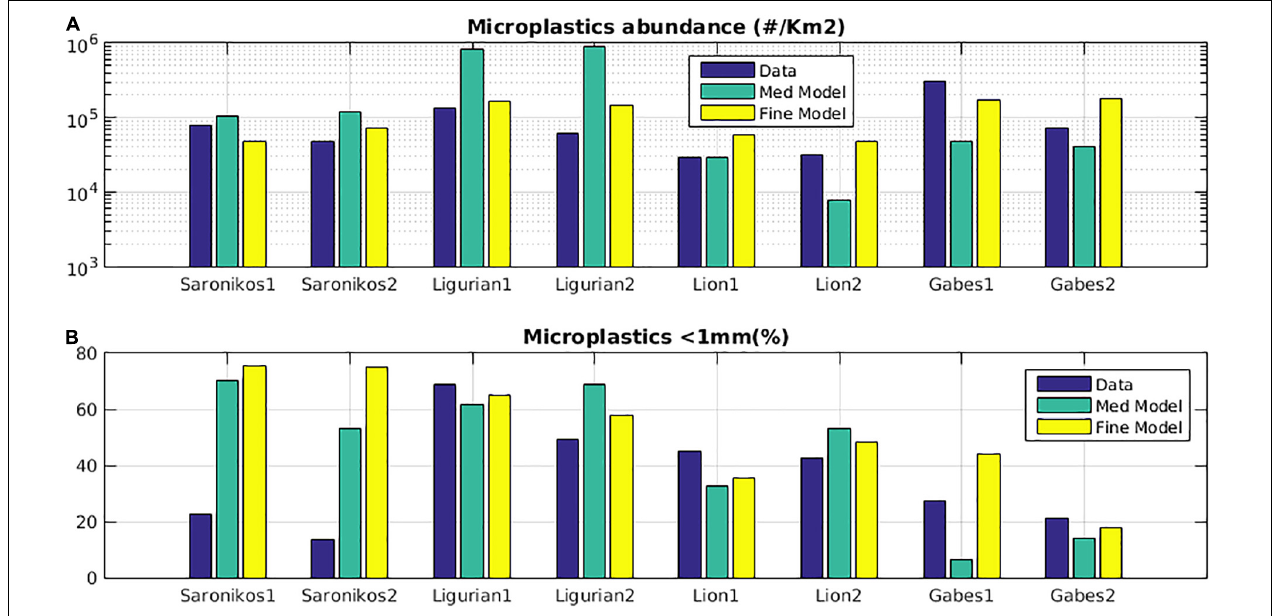
FIGURE 9 | Microplastics (A) mean abundance (items/m 2 ) and (B) small size ( < 1mm) contribution (%), simulated with the Mediterranean (Med model, green bars) and fine-resolution (Fine model, yellow bars) models, against in situ data (blue bars) collected in the four key study areas (Saronikos Gulf, Ligurian Sea, Gulf of Lion, and Gulf of Gabes), during the two